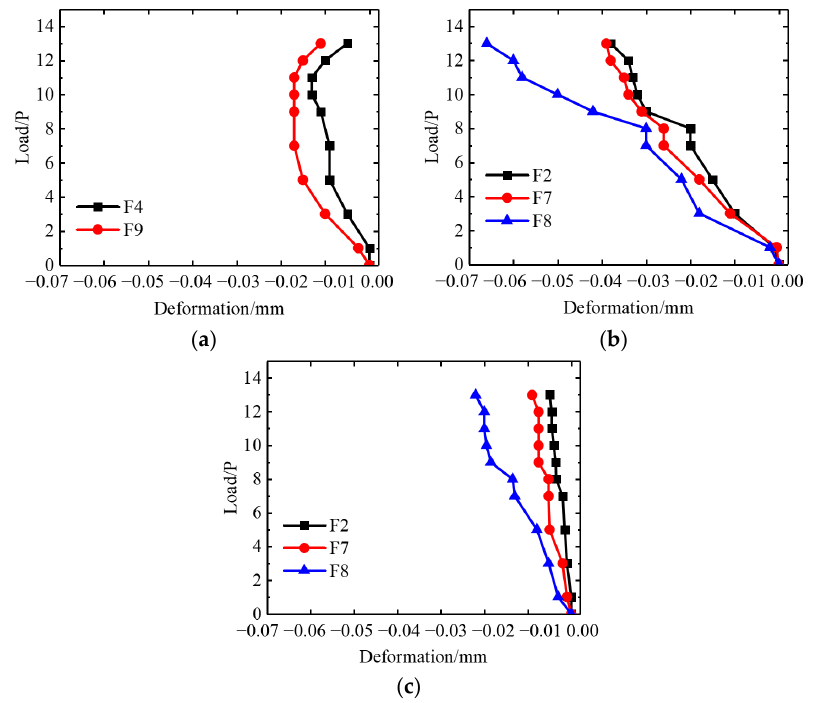
Figure 11. Deformation test results by dislocation gauge: ( a ) Back Anchor Surface; ( b ) Middle Anchor; ( c ) Front anchor surface.